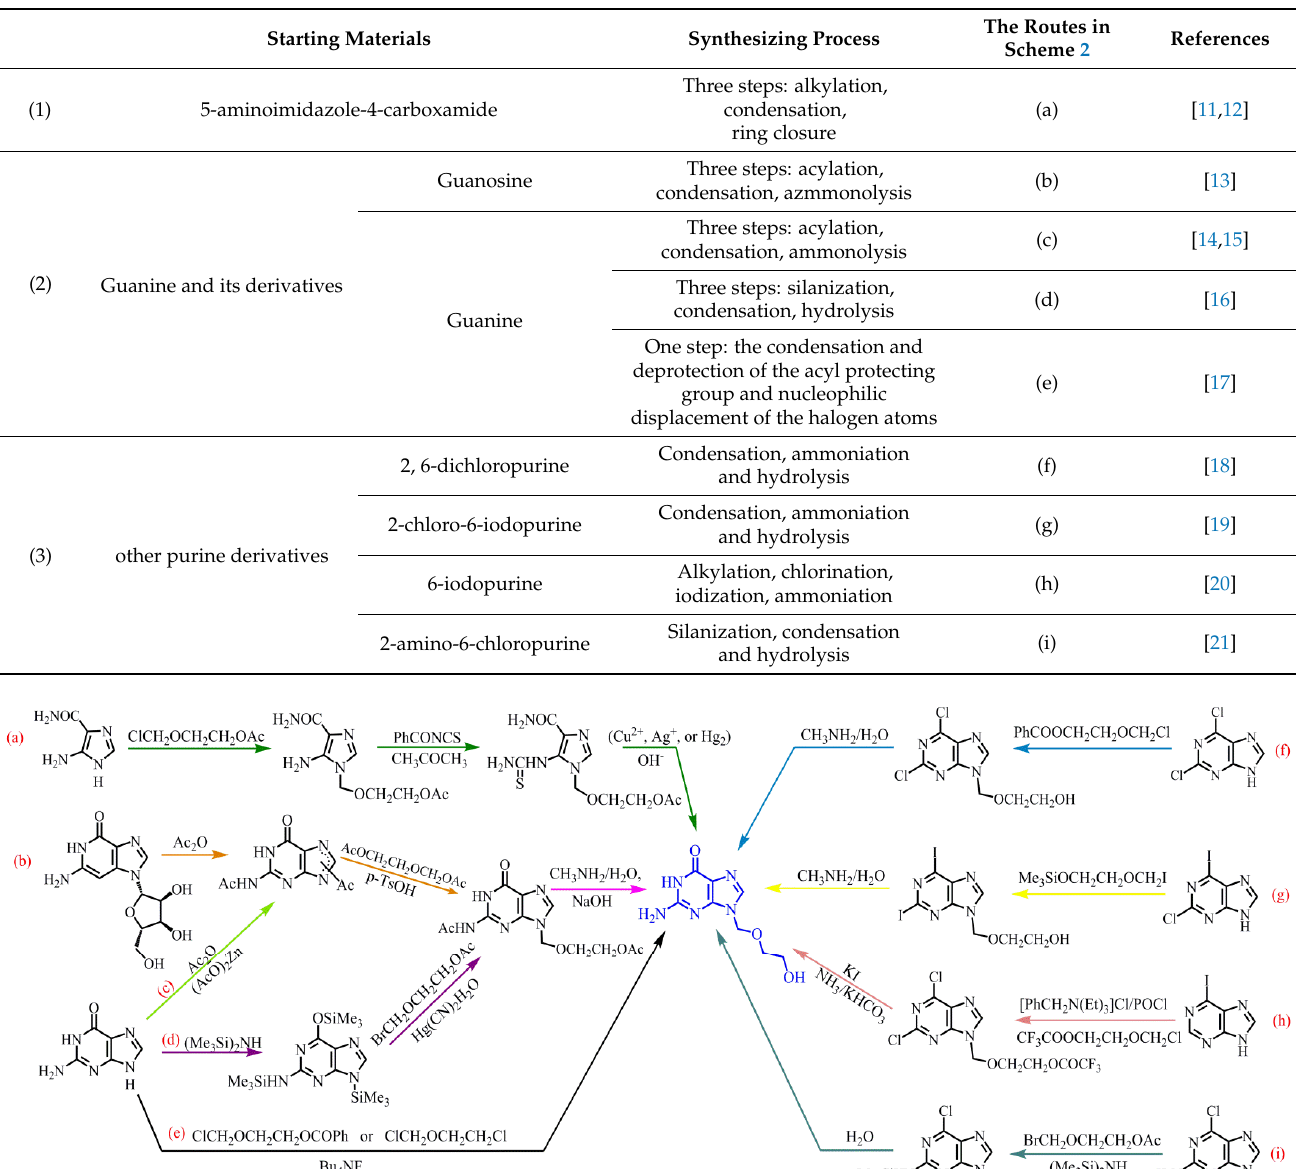
Table 1. Various starting materials for ACV